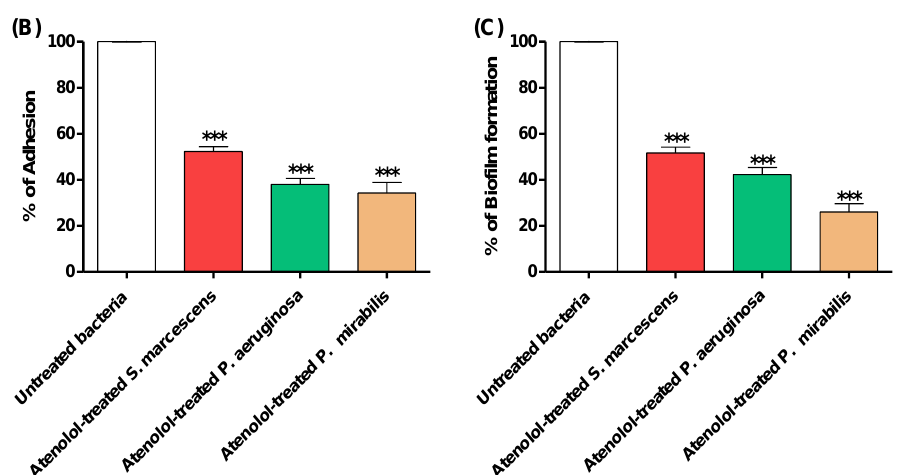
Figure 9. Atenolol decreased the bacterial adhesion and biofilm formation. ( A ) Light microscope images show the marked ability of atenolol to decrease the numbers of adhered bacterial cells to cover slips. ( B ) The absorbances of crystal violet-stained adhered S. marcescens , P. aeruginosa , and P. mirabilis . ( C ) The absorbances of crystal violet-stained biofilm forming S. marcescens , P. aeruginosa , and P. mirabilis . Atenolol significantly decreased the adhesion and biofilm formation (***: p ≤ 0.001). The data are presented as percentage change from untreated controls.